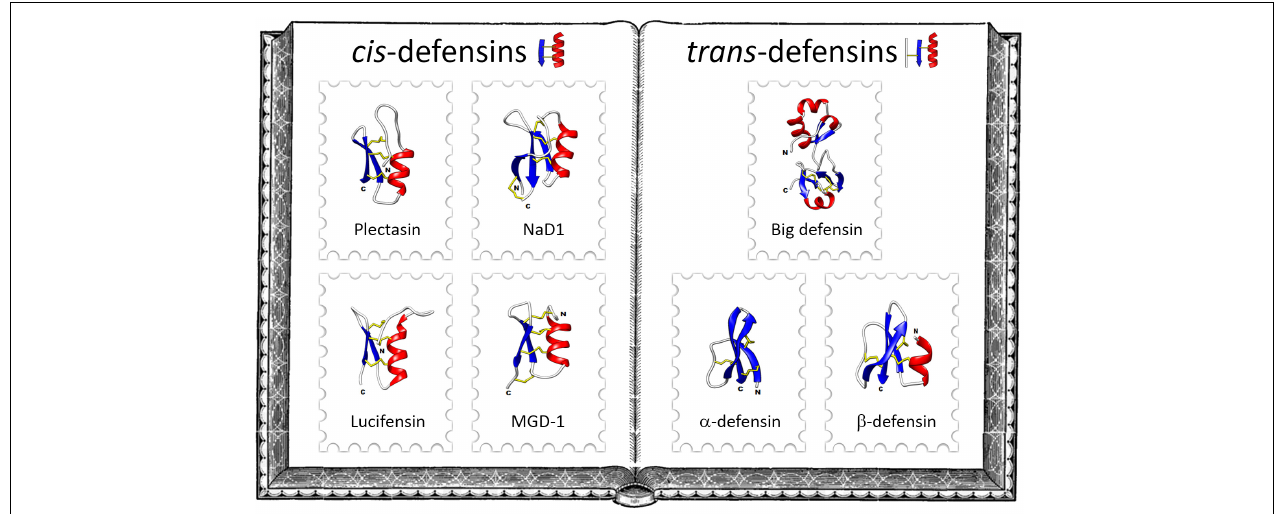
FIGURE 1 | The family album of defensins. Left-hand side of the album illustrates some classical cis -defensins: the fungal defensin plectasin from the ebony cup mushroom Pseudoplectania nigrella (PDB: 1ZFU), the plant defensin NaD1from the flowering tobacco Nicotiana alata (PDB: 1MR4), the insect defensin lucifensin from the green bottle fly Lucilia sericata (PDB: 2LLD) and the mollusk defensin MGD-1 from the Mediterranean mussel Mytilus galloprovincialis (PDB: 1FJN). Right-hand side of the album exemplifies some members of the main families of trans -defensins: the big defensin Cg -BigDef1 from the Pacific oyster Crassostrea gigas (PDB: 6QBL), the α -defensin HD5 (PDB: 2LXZ) and the β -defensin hBD-1 (PDB: 1IJV) from humans. Protein Data Bank (PDB) numbers are indicated in parentheses, α -helices in red, β -strands in blue and disulfide bonds in